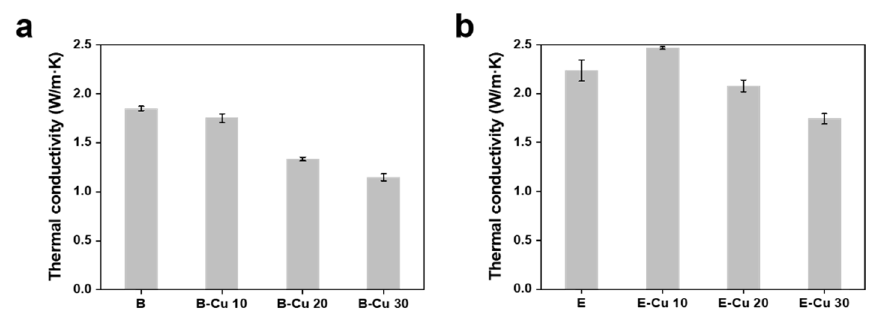
Figure 7. Thermal conductivity of thermal pads using aluminum oxide and copper powder with ( a ) 20 wt% PDMS or ( b ) 15 wt% PDMS. The bar graph illustrating the mean and standard deviation (error bars).